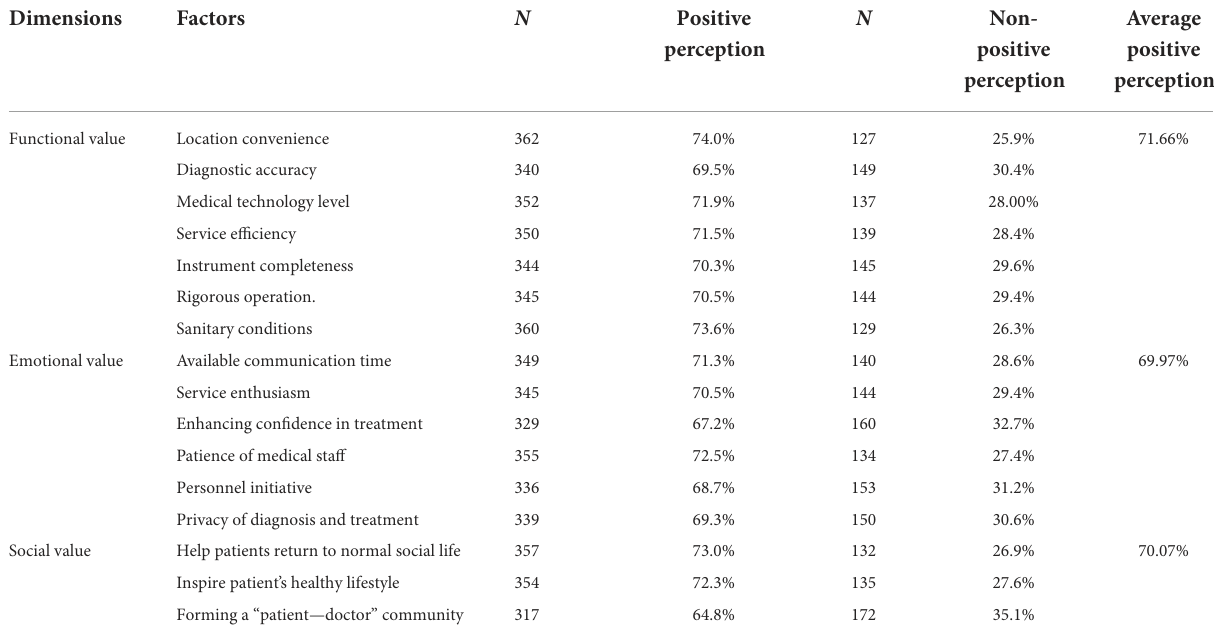
TABLE 5 Value perception of residents.